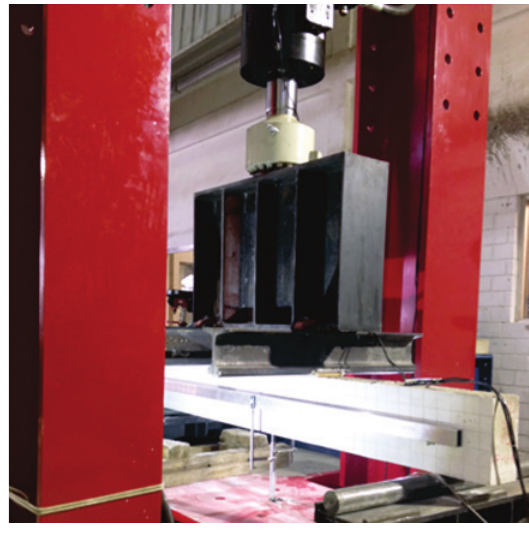
Resultados dos ensaios à flexão em quatro pontos